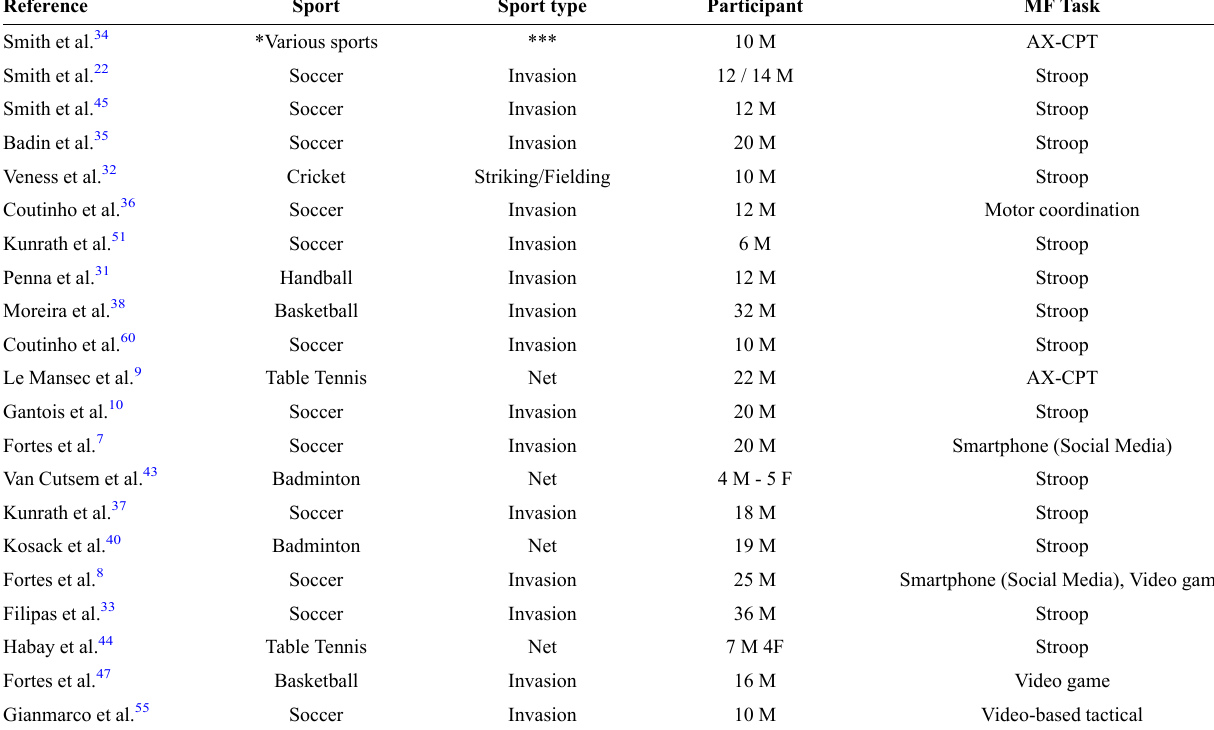
Table 1 - Research on mental fatigue in ball sports with methodological